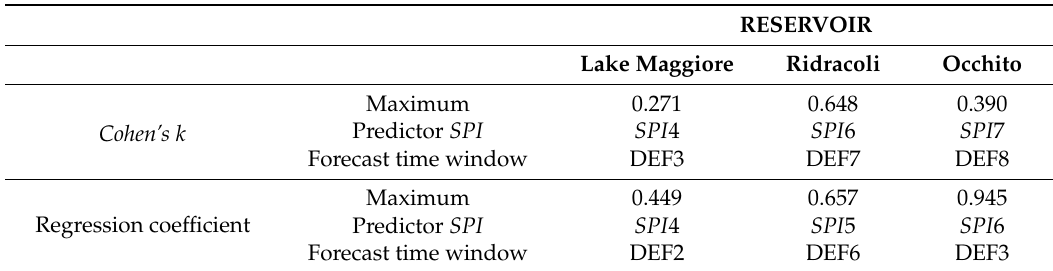
Table 3. Cohen’s k and regression coefficient for the three case